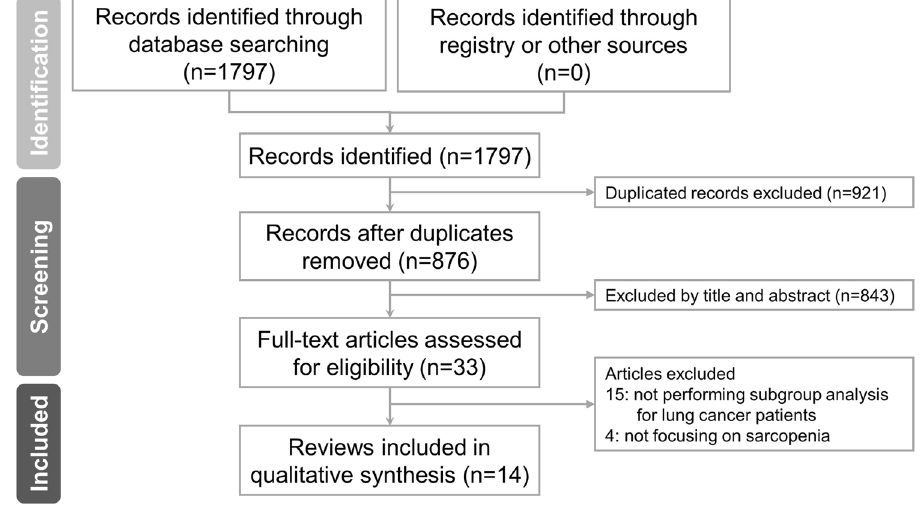
Fig. 1 Flow diagram for the literature